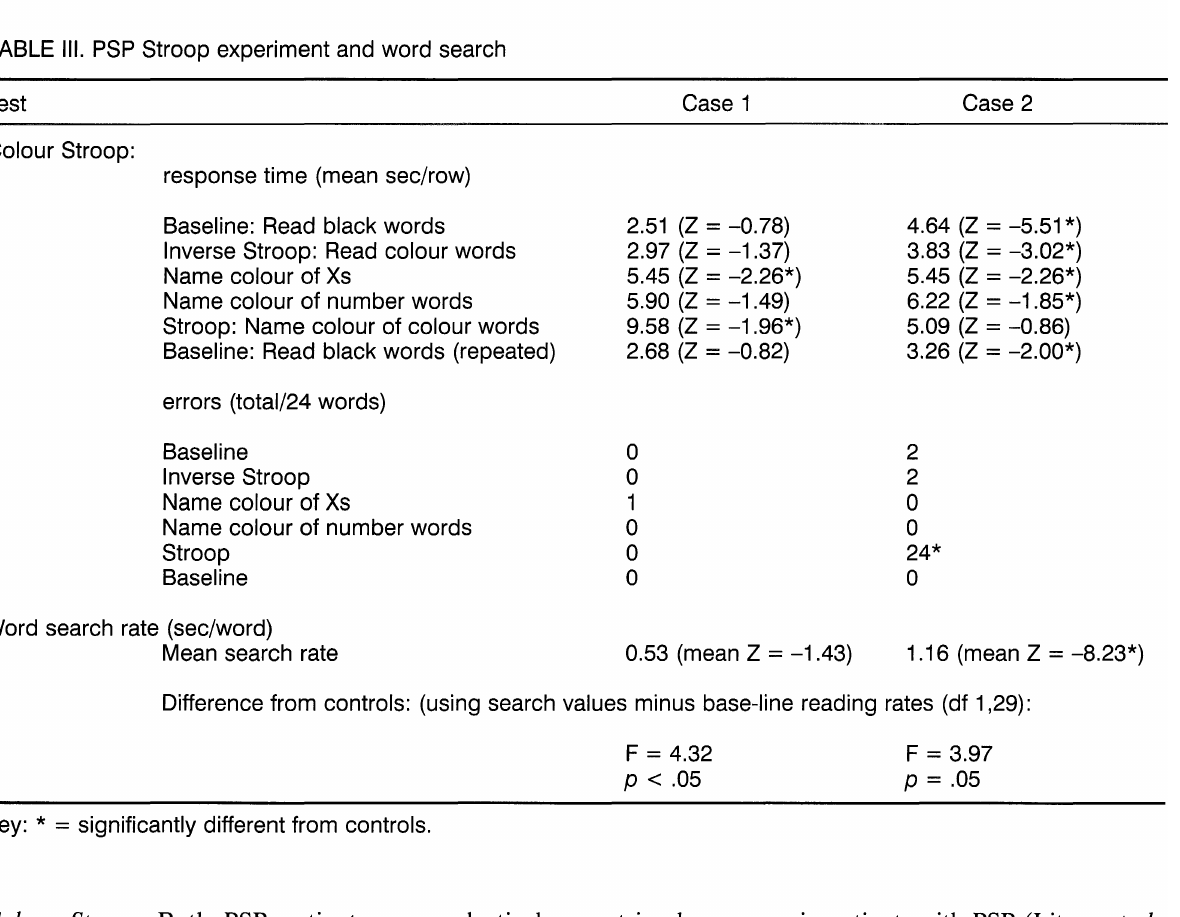
TABLE III. PSP Stroop experiment and word search